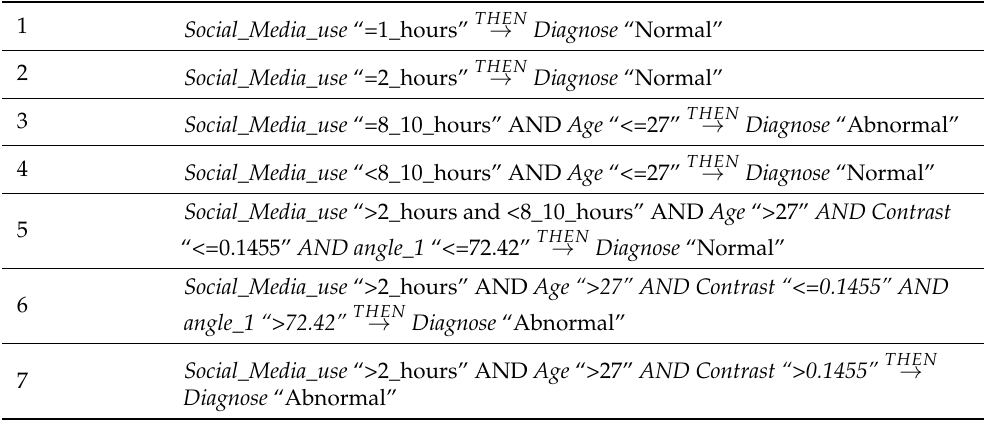
Table 9. Classification (IF-THEN) rules obtained by the C4.5 algorithm for the completed DT shown in Figure